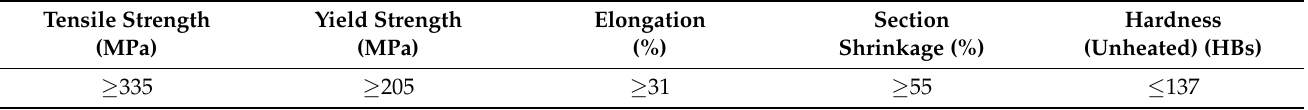
Table 2. Mechanical properties of the 1010 material (at room temperature)